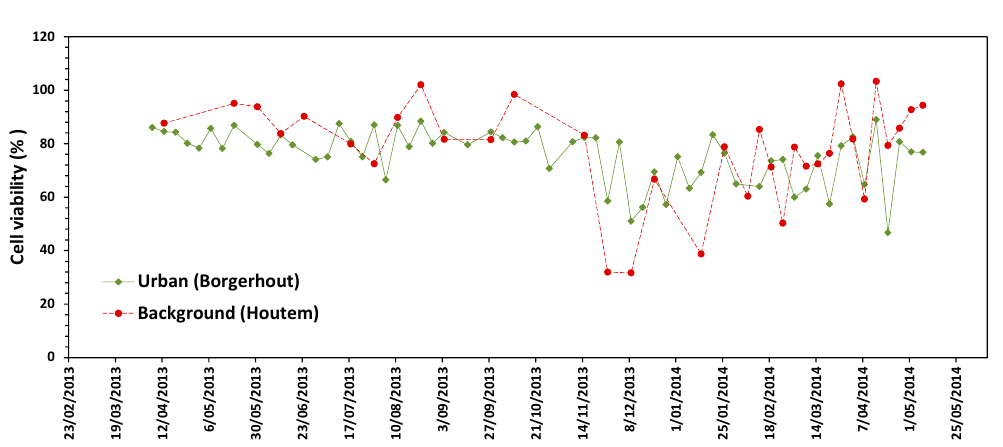
Figure 1. Time series of cytotoxic response of individual PM 10 air samples between April 2013 and May 2014 for each sampling site. Cell viability after exposure of Beas-2B cells to 100 µg/mL PM 10 particulate fraction. Cell viability is expressed as percentage viable cells compared to unexposed control cells. Values represent mean of 6 replicate wells.